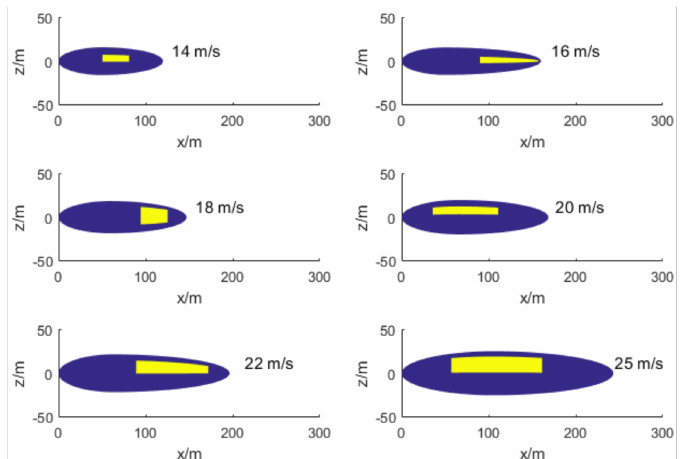
Figure 20. The optimized shape of the airship and layout of the solar array (side view) for different average resisting wind speeds.